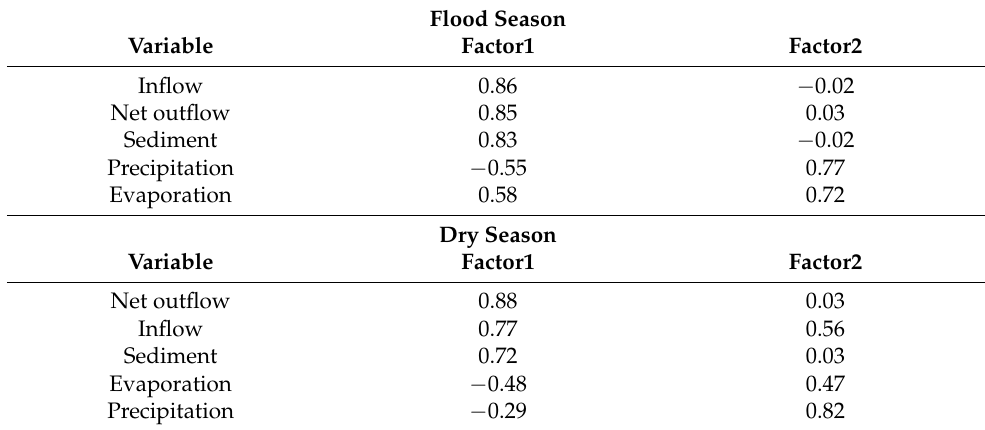
Table 1. Component matrix.